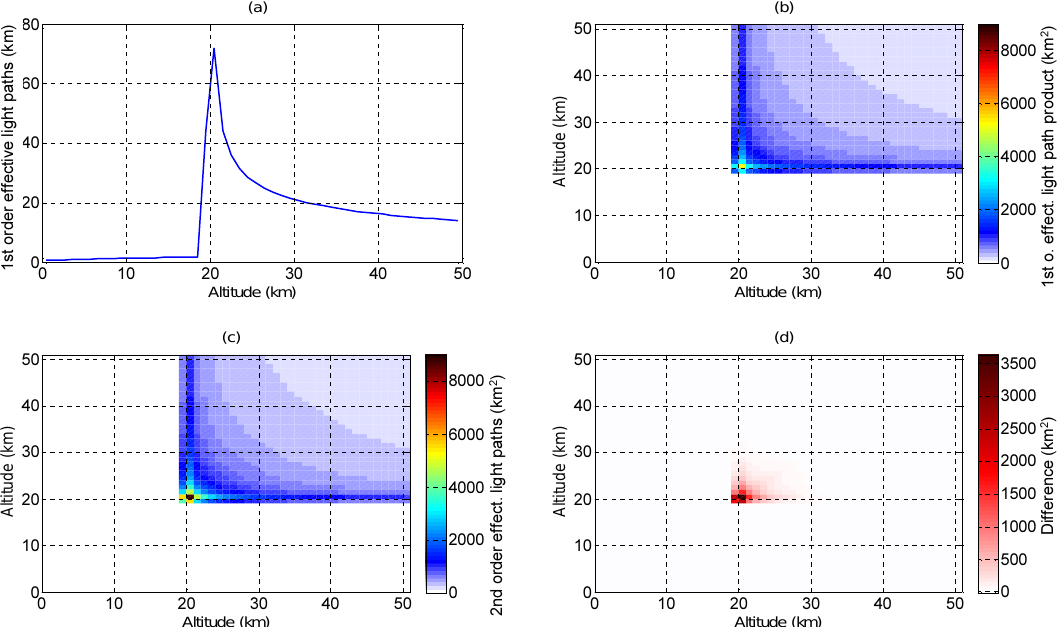
Figure 3. (a) Conventional (first-order) effective light paths at 545nm calculated for the same scenario as in Fig. 2. (b) Product of the first- order effective light paths at two different altitudes. (c) Second-order effective light paths as function of two different altitudes. (d) Difference between the second-order effective light paths and the products of the first-order effective light paths.